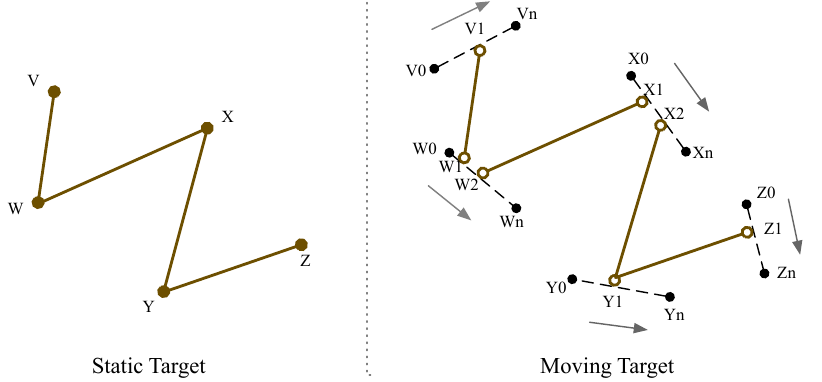
Figure 2. A static target visiting sequence and a time-dependent rendezvous sequence for moving targets.